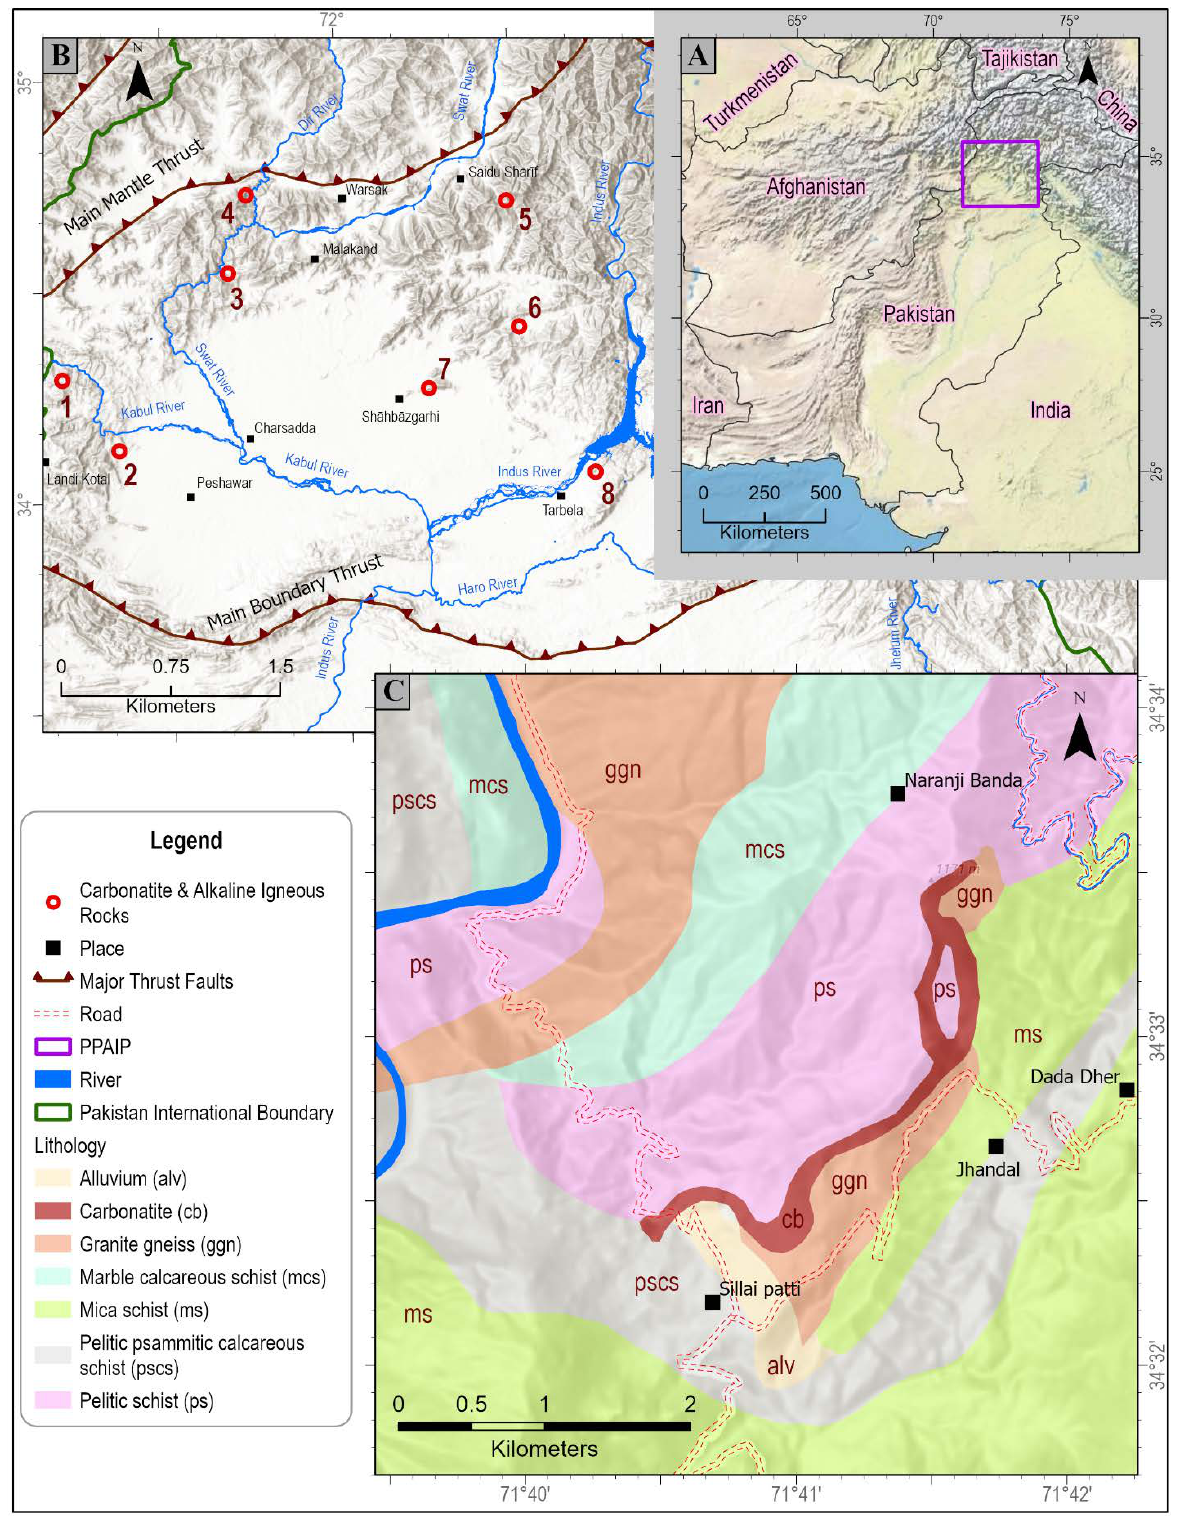
Figure 1. ( A ) Map showing the regional location of the Peshawar Plain Alkaline Igneous Province (PPAIP); ( B ) Carbonatites and alkaline igneous rocks of PPAIP 1. Loe-Shilman, 2. Warsak, 3. Sillai Patti, 4. Jambil, 5. Jawar, 6. Koga, 7. Shewa-Shahbazgarhi, 8. Terbela; ( C ) Geological map showing the Sillai Patti carbonatite and the surrounding rocks.